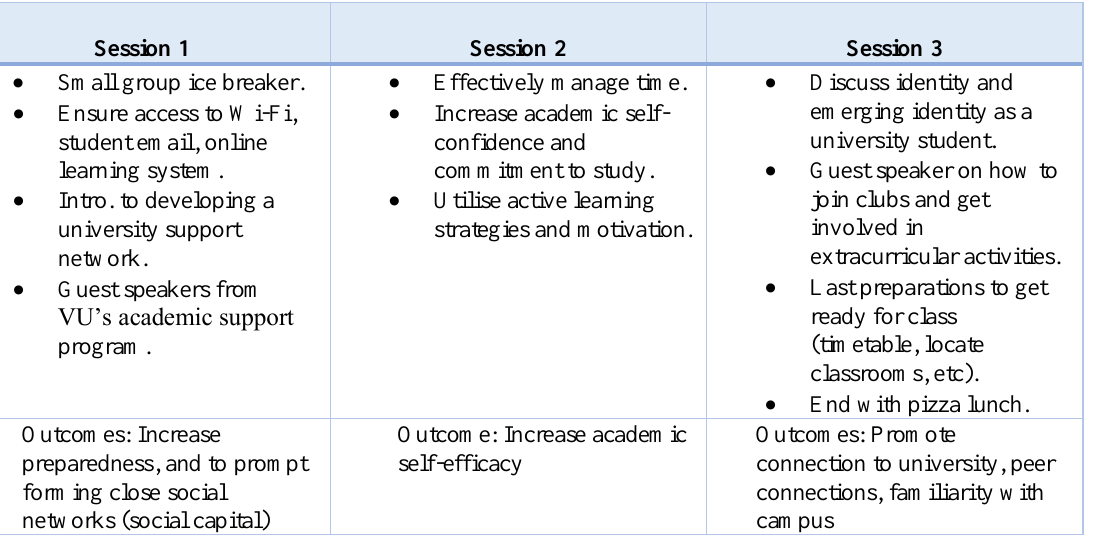
Summary of Kick Start Session Content and